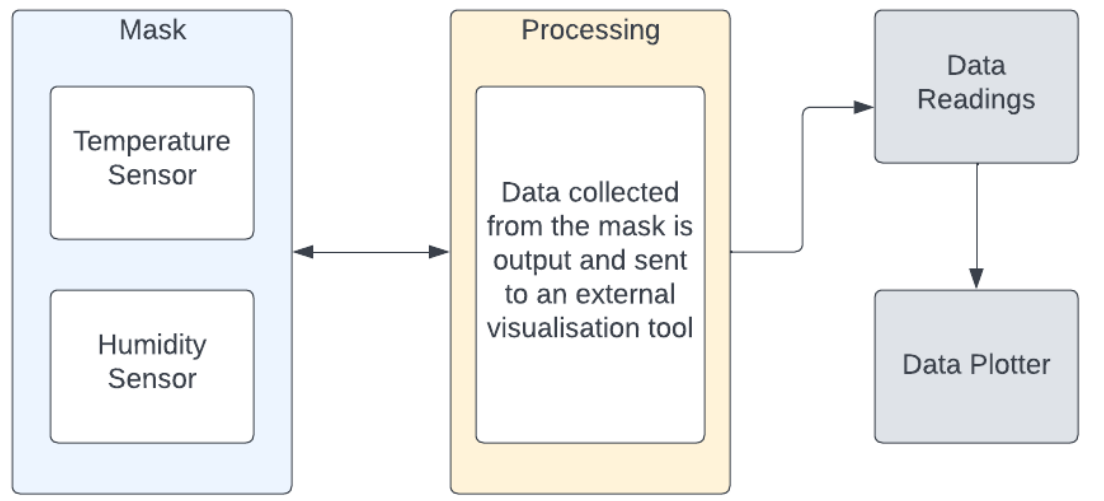
Figure 1. Blueprint Architecture